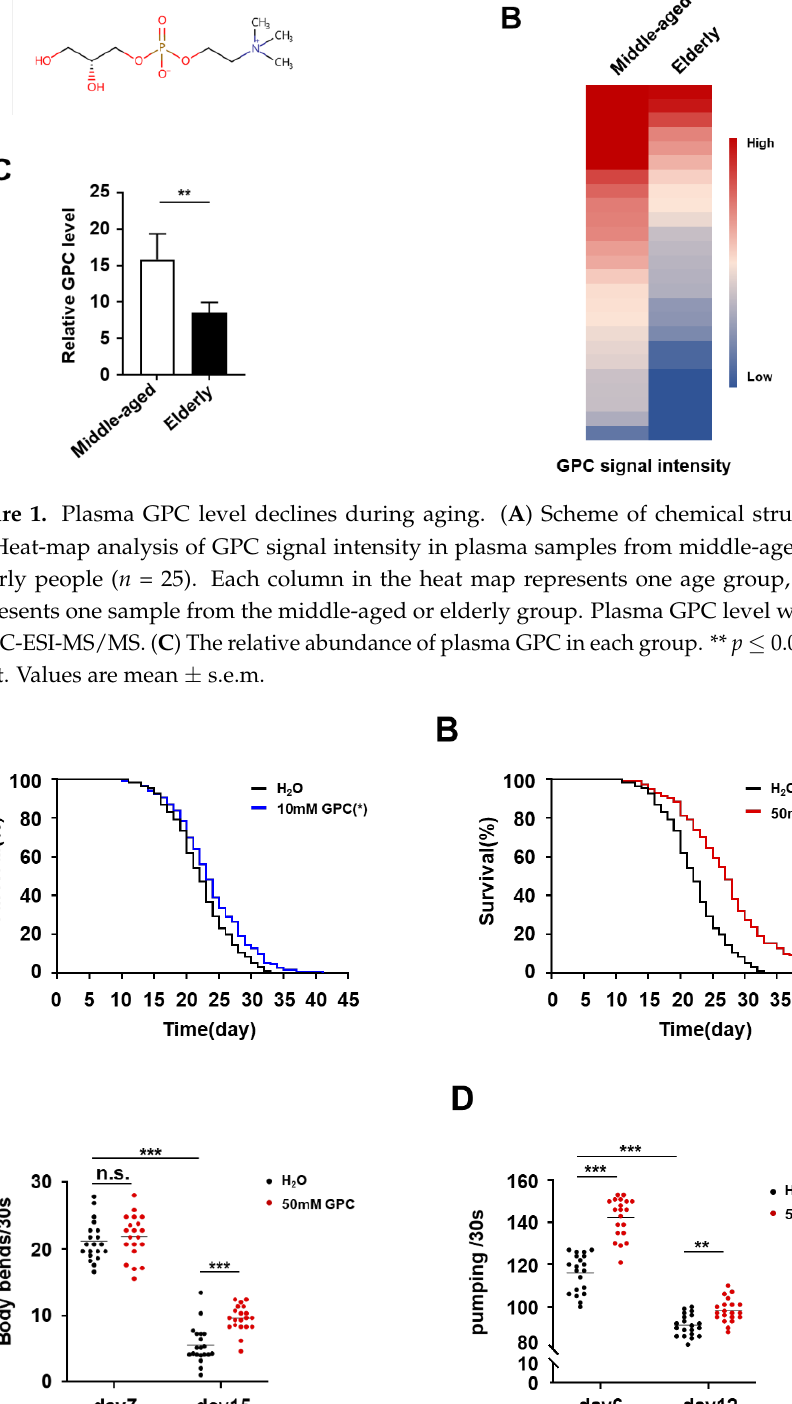
Figure 1. Plasma GPC level declines during aging. ( A ) Scheme of chemical structure for GPC. ( B ) Heat-map analysis of GPC signal intensity in plasma samples from middle-aged ( n = 25) and elderly people ( n = 25). Each column in the heat map represents one age group, and each row represents one sample from the middle-aged or elderly group. Plasma GPC level was detected by UPLC-ESI- MS/MS. ( C ) The relative abundance of plasma GPC in each group. ** p ≤ 0.01; by unpaired t test. Values are mean ± s.e.m.